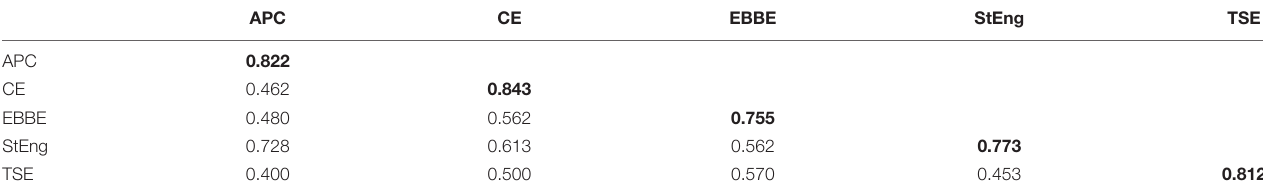
TABLE 3 | Discriminant validity (Fornell and Larcker Criteria).